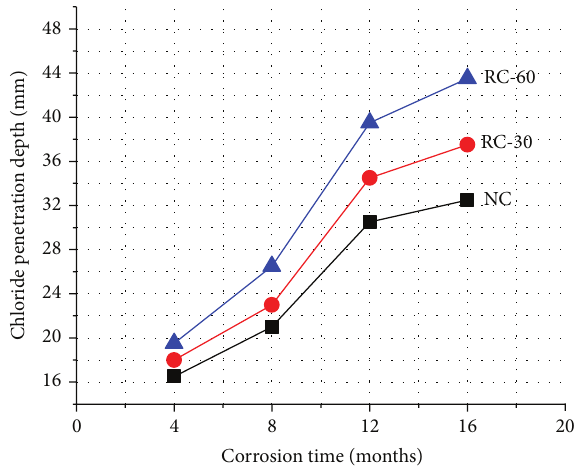
Figure 4: Chloride penetration depth of